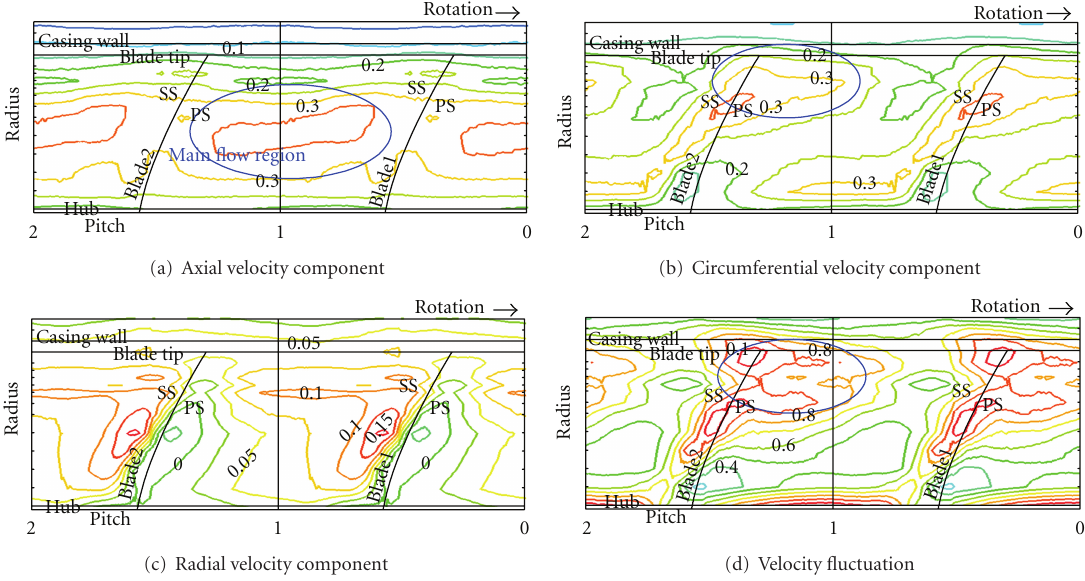
Figure 10: Contour maps of each velocity component and velocity fluctuation at rotor outlet of TypeC at φ = 0 . 290.